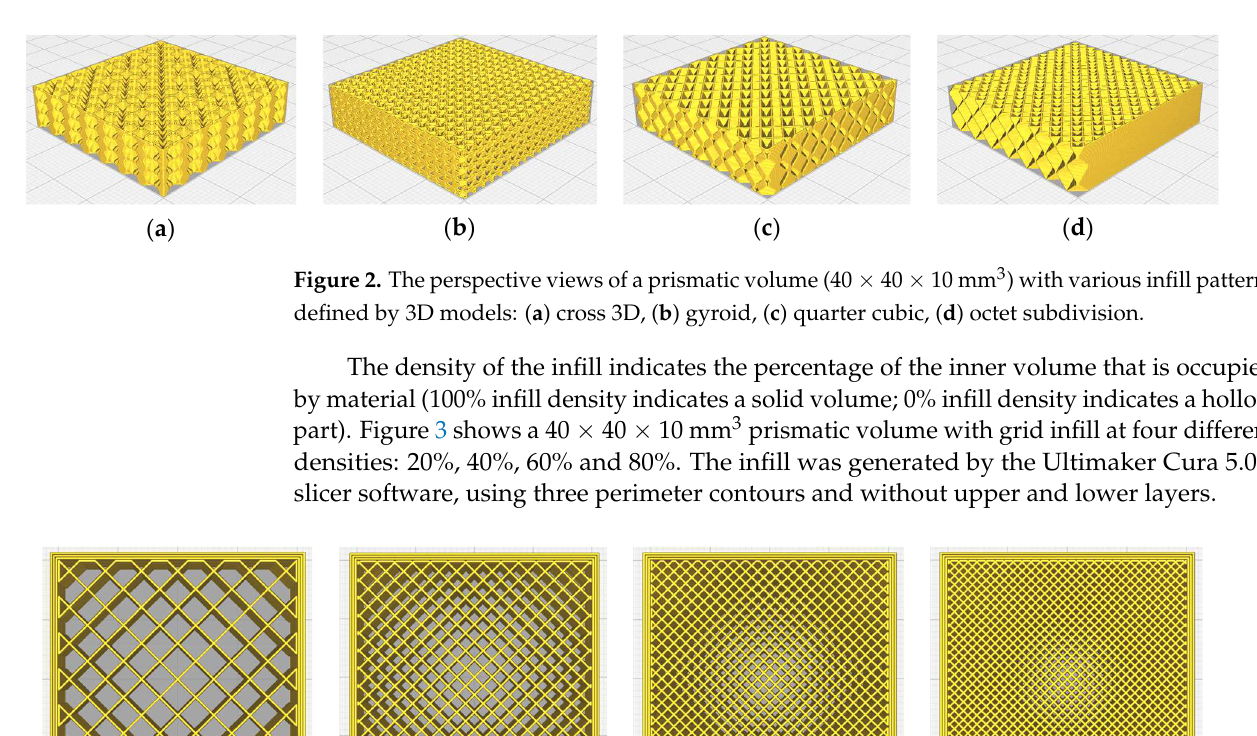
Figure 3. The top views of a prismatic volume (40×40×10 mm 3 ) with grid infill at various densities: ( a ) 20%, ( b ) 40%, ( c ) 60%, ( d ) 80%. The peripheral contours, the lower layers and the upper layers constitute a shell that closes the filling volume and gives the shape of the piece. The ratio of the shell material volume to the infill material volume increases under certain conditions: small parts; low infill densities; high number of top/bottom layers and peripheral contours. In such cases,